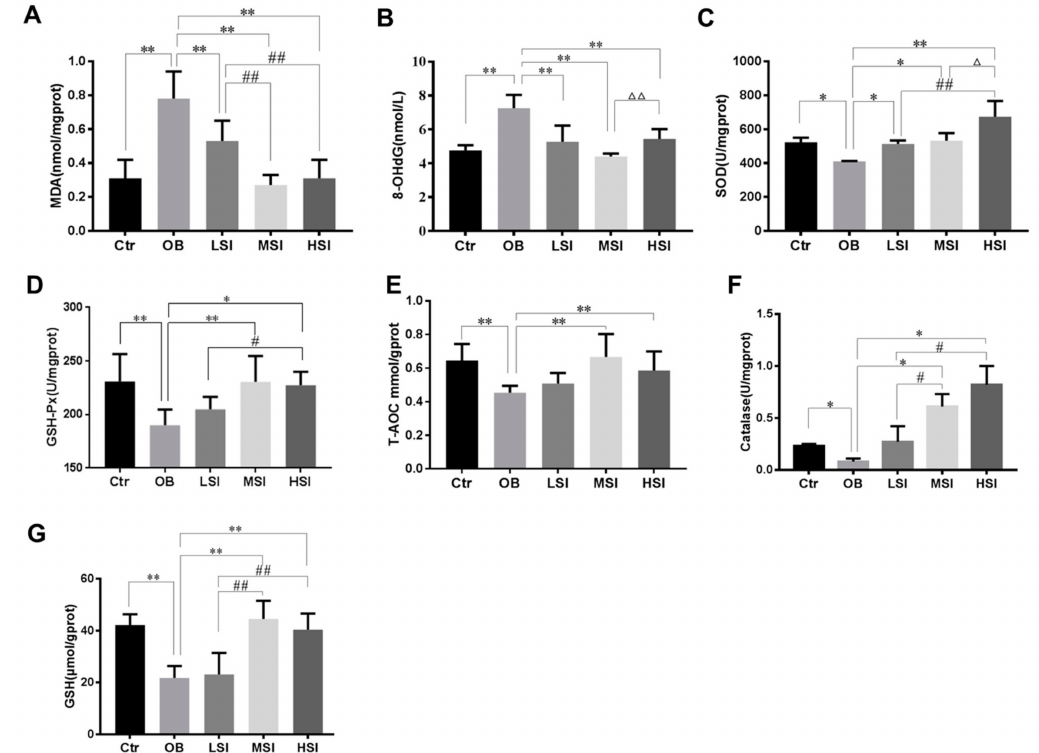
Figure 3. SIF treatment attenuated oxidative stress. ( A – G ) E ff ect of SIF on malondialdehyde (MDA), 8-OhdG, superoxide dismutase (SOD), glutathione peroxidase (GSH-Px), total anti-oxidant capacity (T-AOC), catalase (CAT) and reduced glutathione (GSH) of testicular tissue in rats ( n = 8). Bars represent the mean ± SD, * p < 0.05, ** p < 0.01 vs. OB; # p < 0.05, ## p < 0.01 vs. LSI; ∆ p < 0.05, ∆∆ p < 0.05 vs. MSI, one-way ANOVA analysis and LSD test.